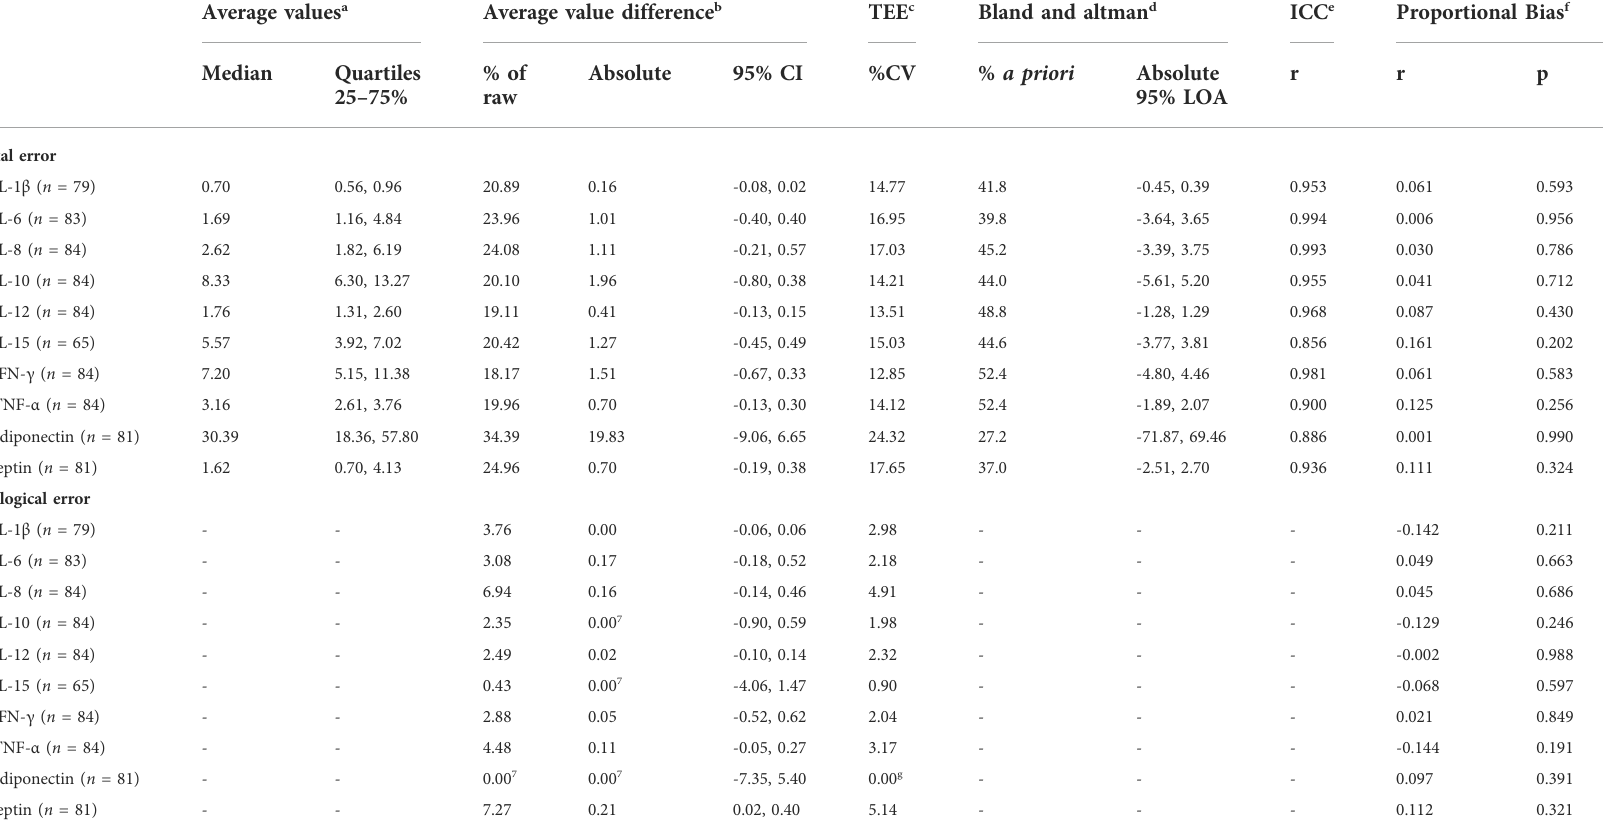
TABLE 2 Same- and between-day reliability of in fl ammatory biomarkers, within a general population group (18 – 85 years, equal sex